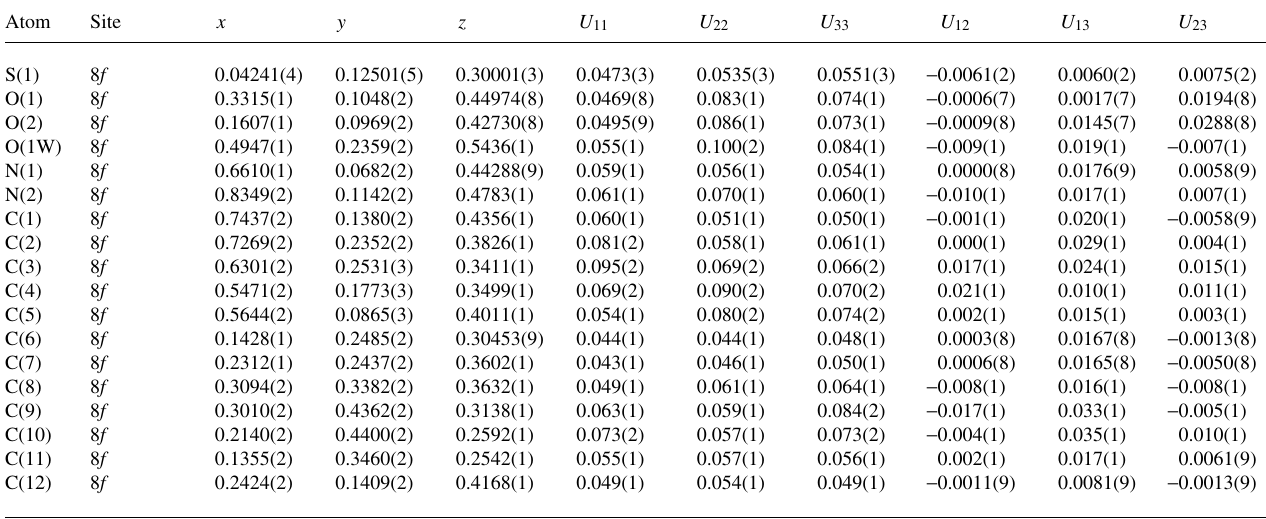
Table 3. Atomic coordinates and displacement parameters (in Å 2 ) .